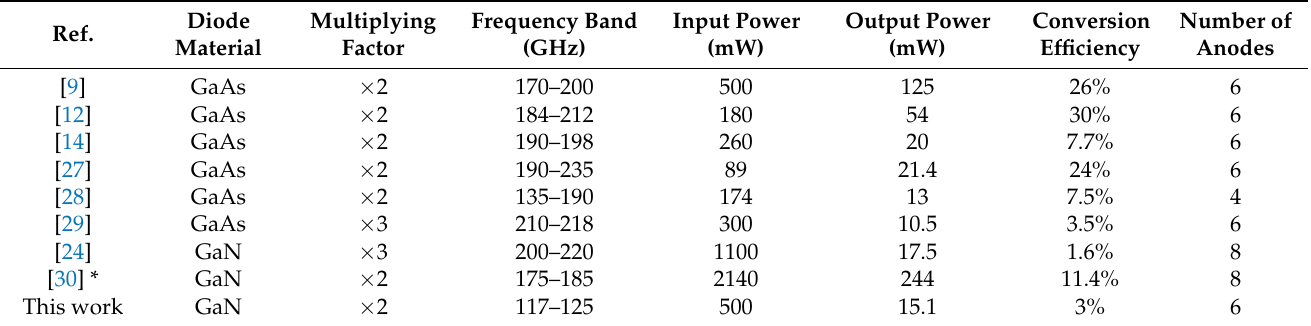
Table 2. Performance comparison of similar frequency